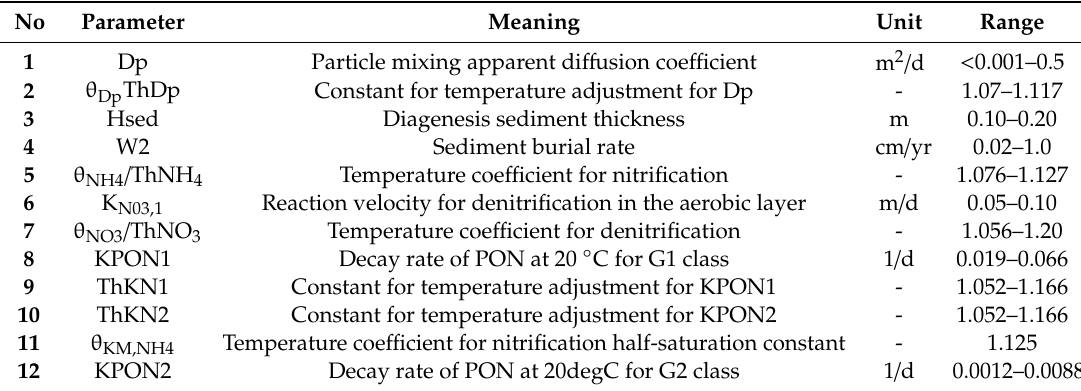
Table 1. Environmental Fluid Dynamics Code (EFDC) sediment diagenesis model related variables and